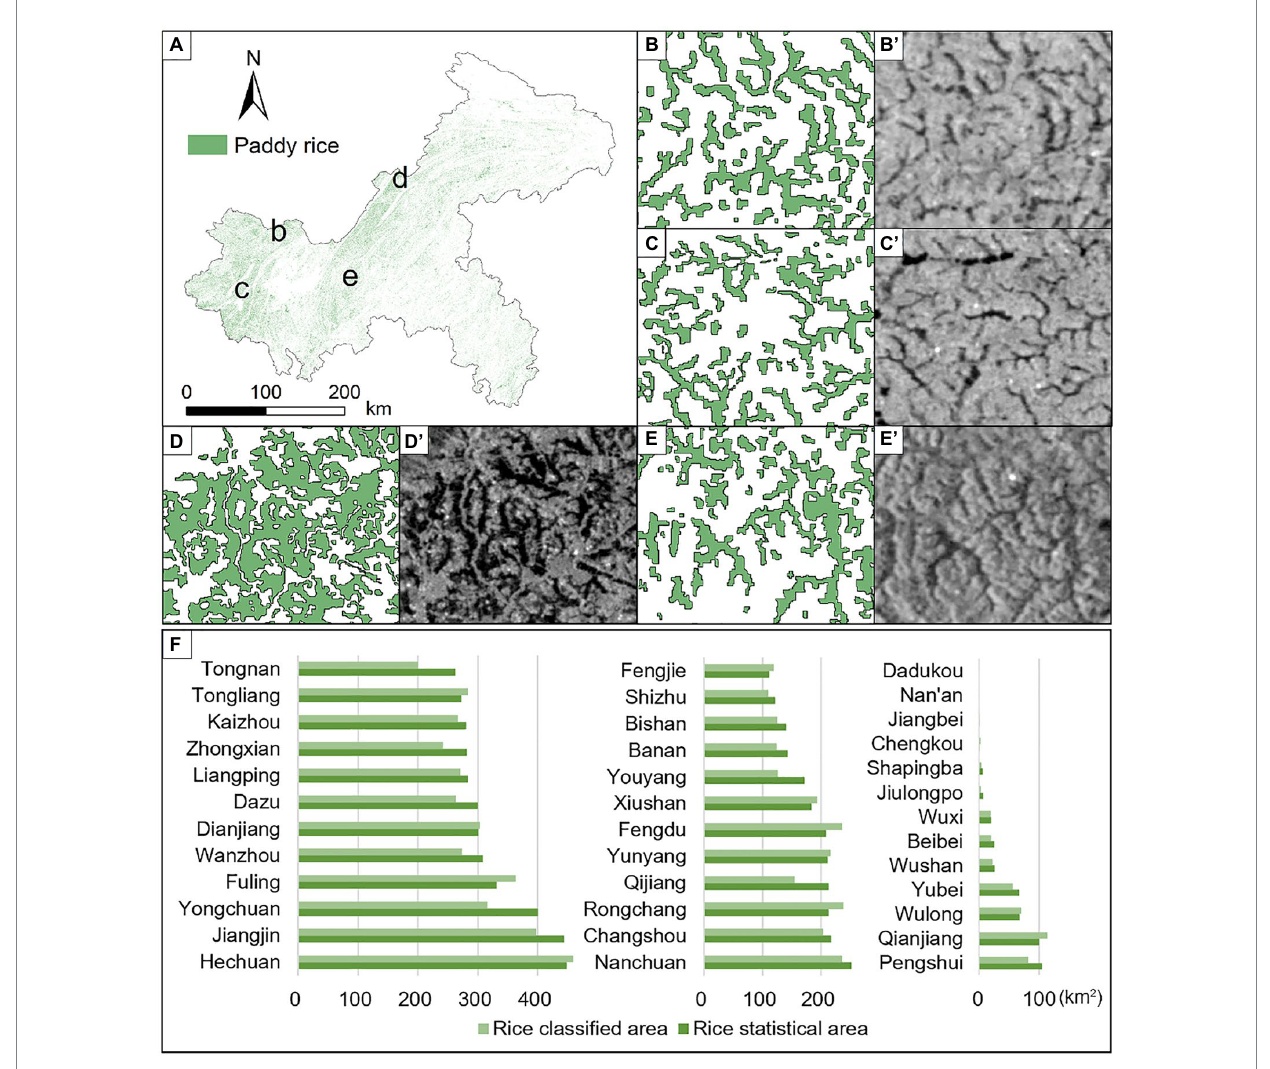
FIGURE 8 The rice fields map of Chongqing in 2020 based on the MPHO-DPSAR algorithm. Four regions, denoted as b–e in (A) , randomly selected for zoom-in views shown in (B–E) , respectively. The corresponding SAR image in transplanting stage shown in (B’–E’), respectively. The (F) is a comparison chart between the mapping results of the algorithm and the mapping results of the